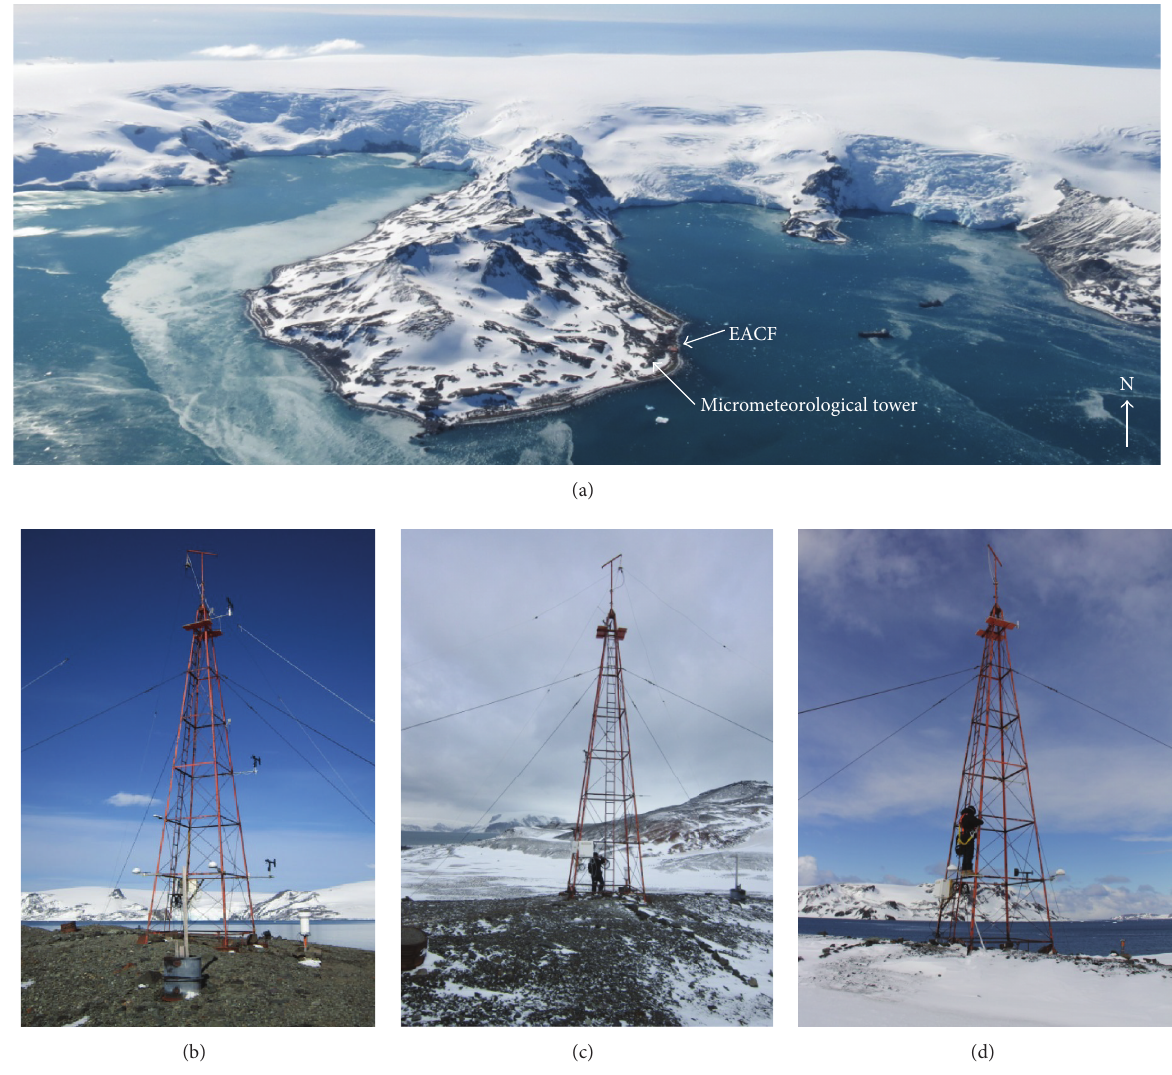
Figure 2: (a) Overview of the investigated area (photography copyright Renato Torlay). Micrometeorological tower region surrounded by (b) bare soil, (c) bare and snow-covered soil, and (d) snow-covered